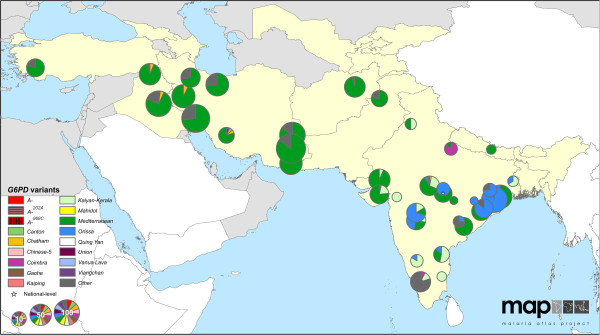
G6PDd variant proportion map: West Asia (map series 1). A higher resolution map of Figure 
4.